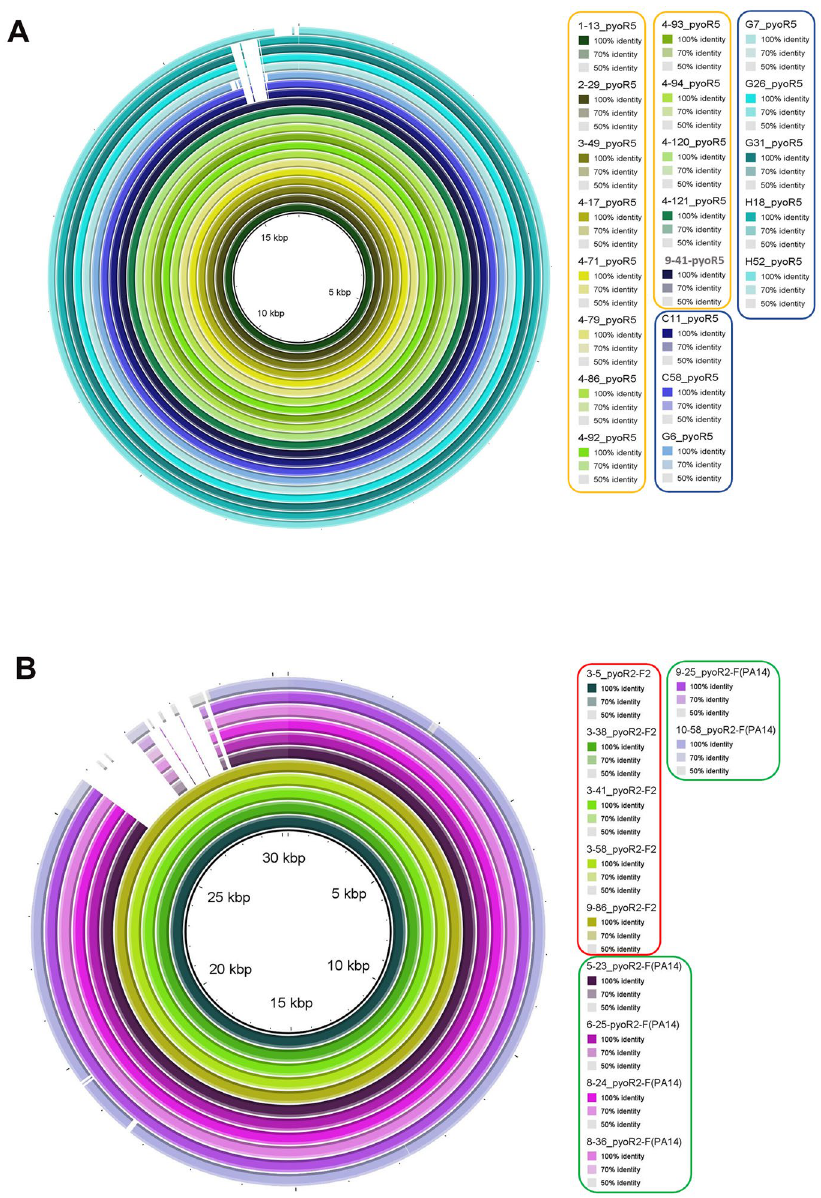
corresponding to group C are rounded in red and to group D in